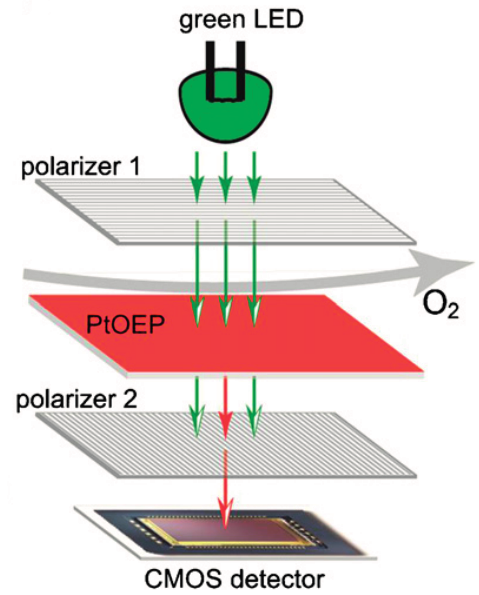
Figure 1. Conceptual design of a fluorescence based detection device showing a light source (LED), photodetector (CMOS), polarizers and O a portable O sensing system. Reprinted from [66], with permission from 2